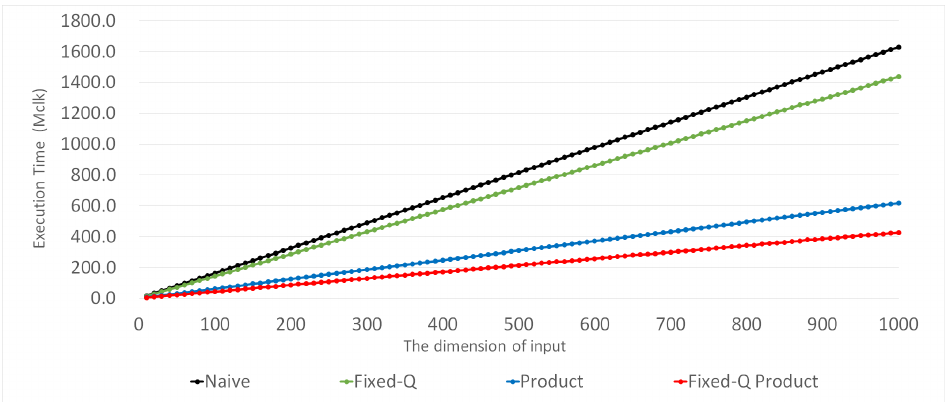
Figure 2. Performance comparison according to the dimension of input for each method.